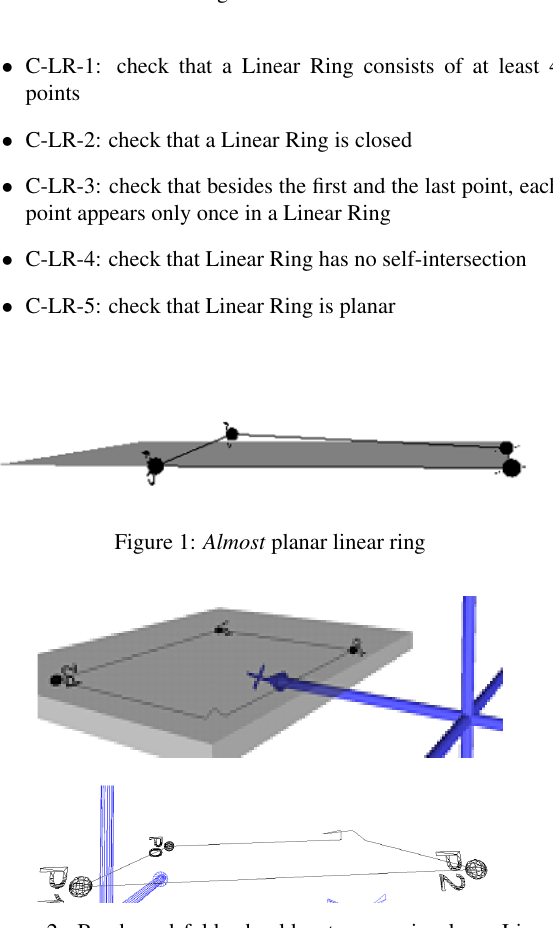
Figure 2: Bends and folds should not appear in planar Linear Rings